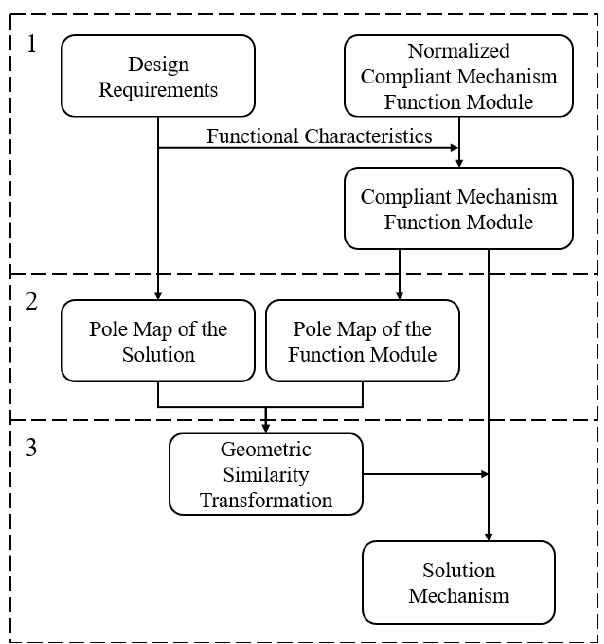
Figure 7. Main contents of the geometric